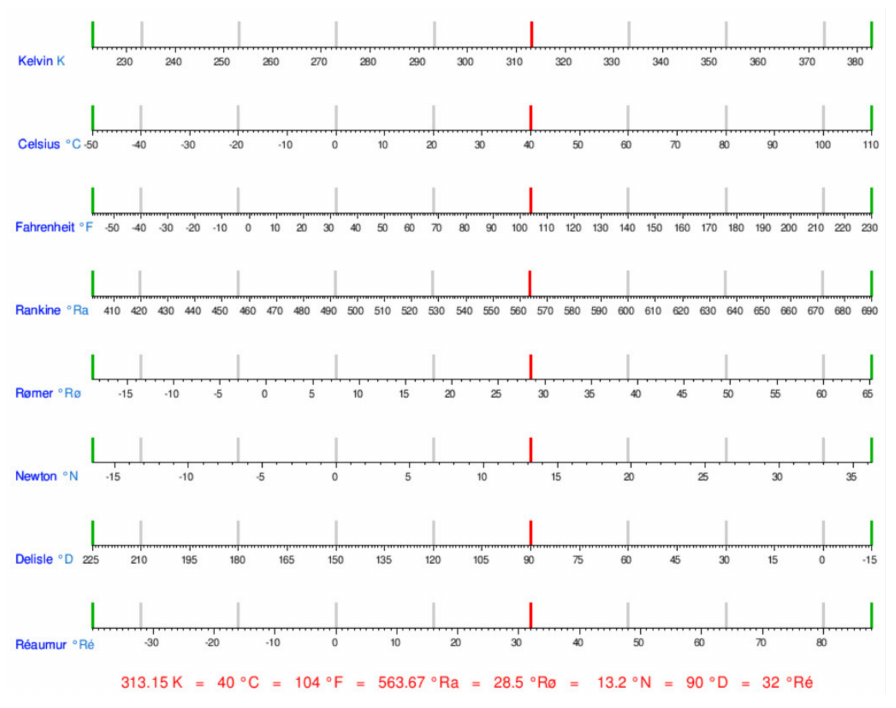
Figure 9. Conversion of temperature scales [14].